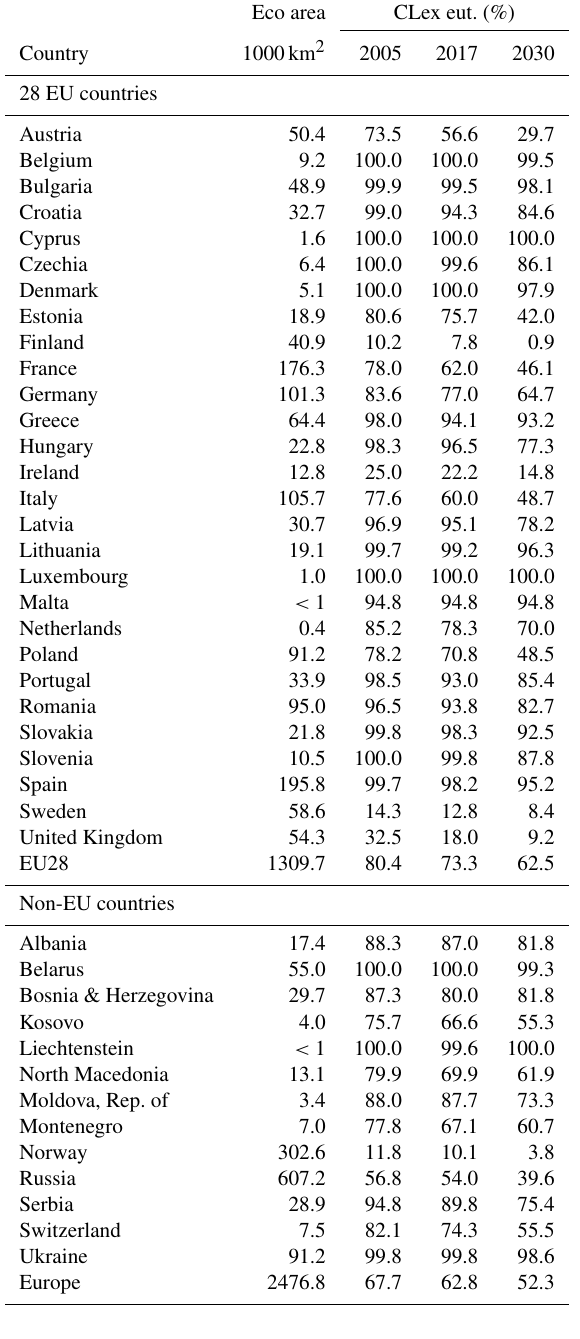
Table 3. Exceedance of CL for eutrophication (CLex eut.) by de- position (Dep.) of total nitrogen. Exceedance are expressed as share (%) of the receptor